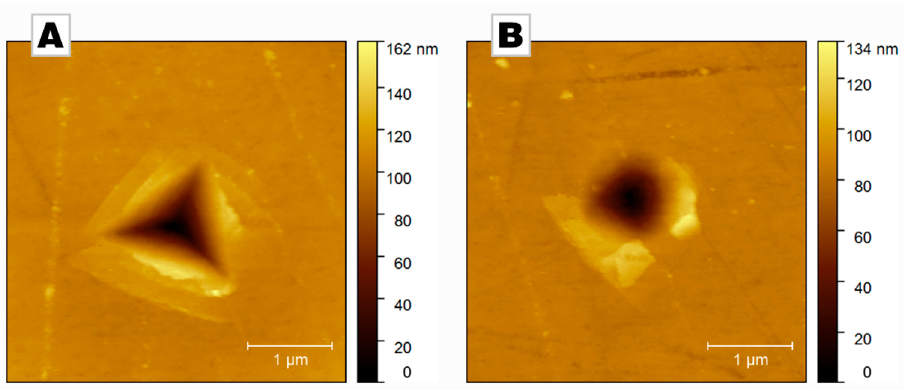
Figure 4. Atomic force micrographs of residual indents in biogenic calcite ( Pinna nobilis ) after indentation up to a depth of 250 nm with ( A ) a Berkovich and ( B ) a conical indenter. Upon unloading, a fraction of this depth is recovered elastically.